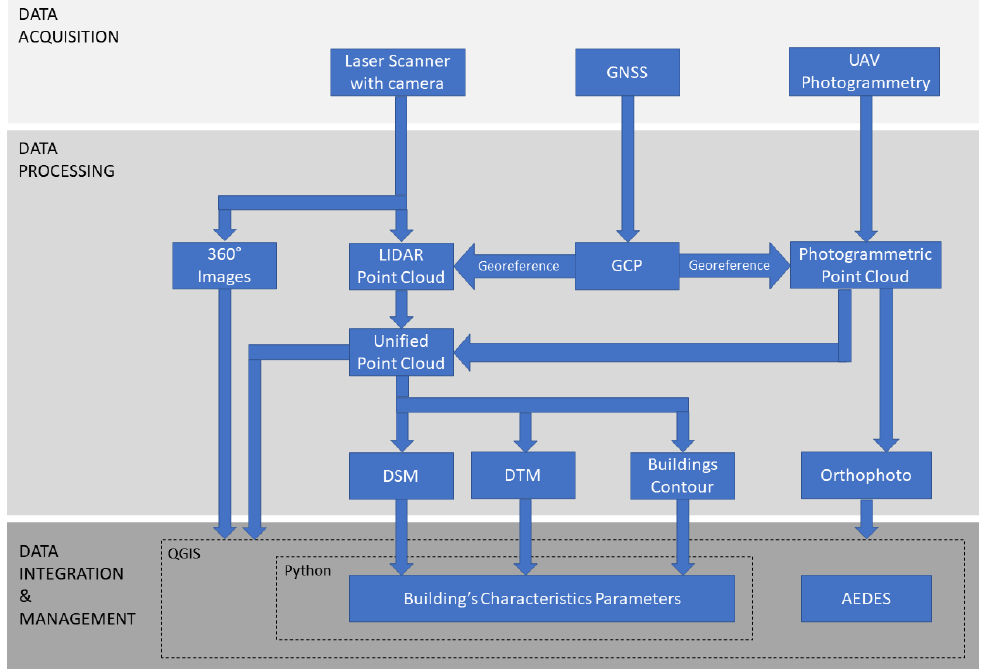
Figure 1. Methodology